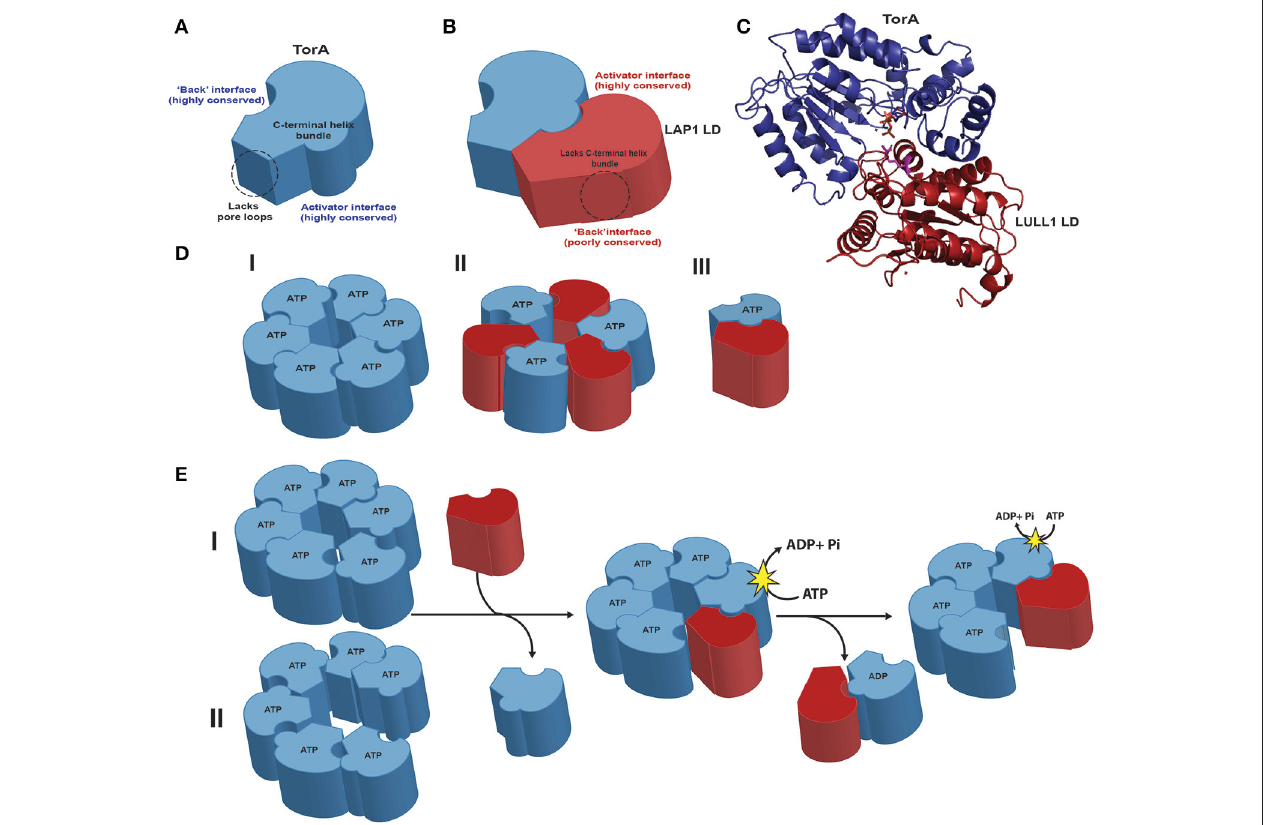
FIGURE 1 | Structural features of TorsinA and its dynamic complexes with cofactors (A). TorsinA (blue) exhibits high levels of conservation both on the activator and “back” interface. Torsins have a C-terminal helix bundle that serves to form intra-protomer contacts in related AAA + proteins but lack the aromatic pore loops that usually serve to thread substrates through the central pore. The membrane-associated N-terminal hydrophobic domain was omitted for clarity. (B) The cofactor LAP1 (maroon) luminal domain, which adopts a AAA + fold, lacks the critical four-helix bundle and exhibits a low level of conservation on its “back” interface opposite the more conserved activator binding face. (C) Cartoon representation of the TorsinA-LULL1 crystal structure (PDB code 5J1S; the nanobody used for crystallization was omitted for clarity). Note that the luminal domains of LAP1 and LULL1 are 60% identical. The cofactor/Torsin complex features a tightly apposed interface in the presence of ATP (orange), with the cofactor supplying a catalytic arginine finger (magenta) that reaches into the nucleotide binding site of Torsin to activate its ATPase activity. (D) Three different models exist for the active assembly of Torsins: (I) a homo-oligomeric (likely hexameric) ring; (II) a trimer of heterodimers; (III) a Torsin-LAP1 heterodimer. (E) Predicted model of active Torsin complex formation with its cofactors. Torsin forms homo-oligomeric complexes in the presence of nucleotide that could adopt either a planar (I) or a stacked spiral (II) conformation. Cofactor binding to the Torsin active site destabilizes the Torsin ring. Torsin-Torsin rings are eventually dismantled because the cofactors lack the necessary four-helix bundle and conserved residues to form stable closed ring structures. The Torsin-cofactor complex is also transient and dynamic: ATP hydrolysis generates ADP-bound Torsin, destabilizing both the Torsin-Torsin and the Torsin-cofactor interaction. Note that the transmembrane domain of LAP1 was omitted for